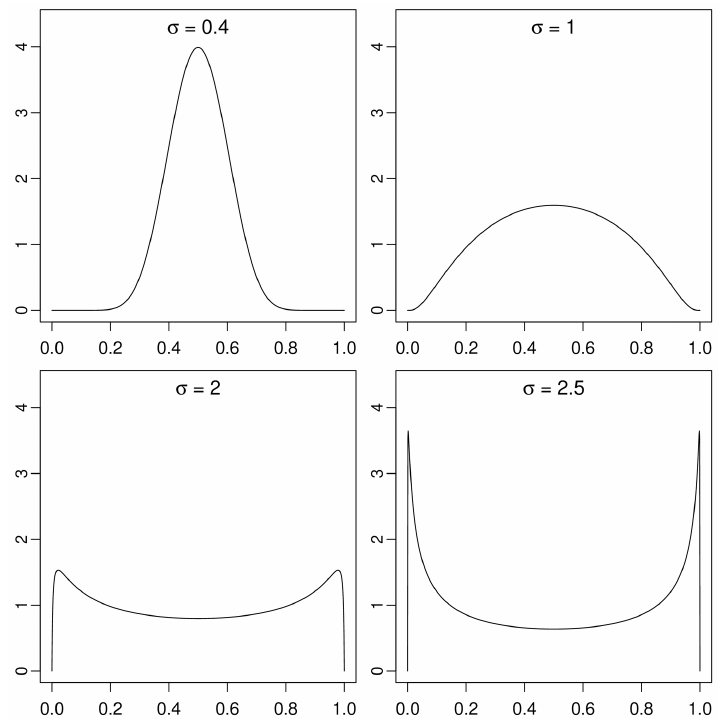
Figure 3. Theoretical distribution of the logit-normal cascade weights W in Eq. (7) for µ = 0 and different values of SD σ